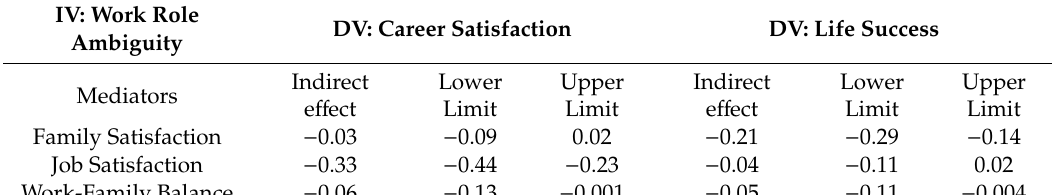
Figure 4. Mediational model of work role ambiguity and career satisfaction.